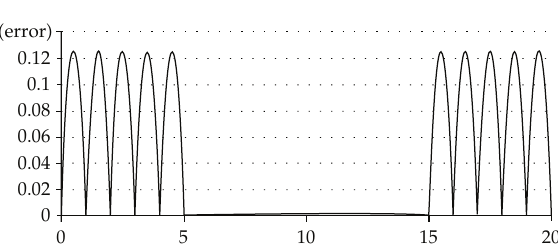
Figure 5: The error of approximation by the hybrid method. The error of FEM is higher than that of FMLSRKM because of the orders of bases for two methods.